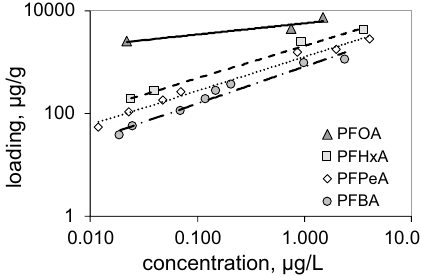
Fig. 1 Adsorption isotherms for PFAS in double‑log depiction (matrix: demineralized water; multicomponent system, initial concentration: 6 µg/L each compound; AC: AC‑bit1 pulverised; contact time: 24 h)